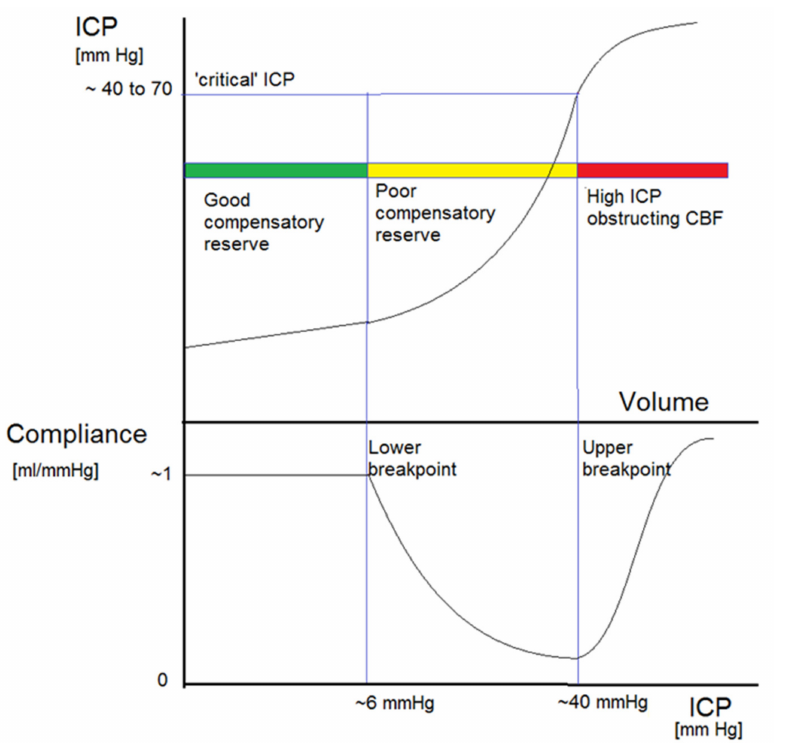
Figure 1. General shape of the pressure-volume curve (upper panel) and related brain compliance (change in intracranial volume over change in intracranial pressure, lower panel). There are three distinct zones. ICP first increases linearly with extra volume (zone of good compensatory reserve). Upon further volume load, the curve becomes exponential, indicating poor compensatory reserve. Past this zone, with further volume load, ICP is critically high, leading to arterial bed compression, decreased blood flow, and a high threat of brain ischaemia. This graph is a compilation of many previous works, starting from Lofgren and Zwetnow through Marmarou et al., and many more contemporary authors